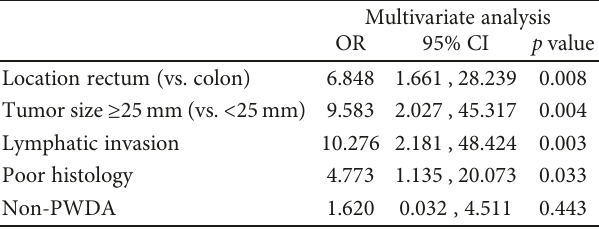
Table 3: The multivariate analysis of the risk factors of LNM in T2